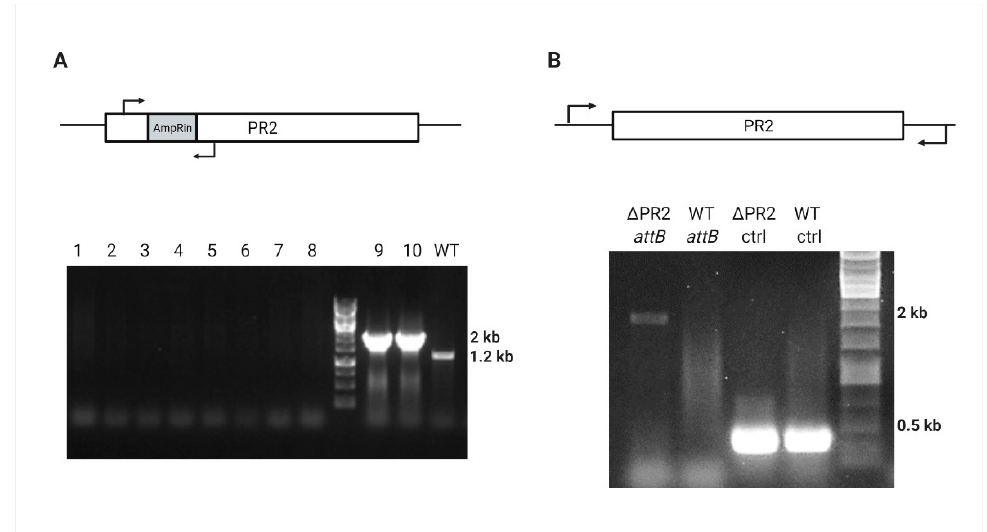
Figure 4. PR2 curing verification by PCR. ( A ) AmpRin region amplification results either in null, 2000 bp, or 1200 bp in the cured, ampR -containing, or WT strain, respectively; lanes 1–8 represent randomly picked Crb-sensitive colonies, lanes 9–10 represent Crb-resistant colonies, and the WT 39016 is for positive control. ( B ) Amplification of 2000 bp around the PR2 attB site of ∆ PR2 and WT 39016, and positive control (ctrl) amplification of 324 bp PA39016_100004 external